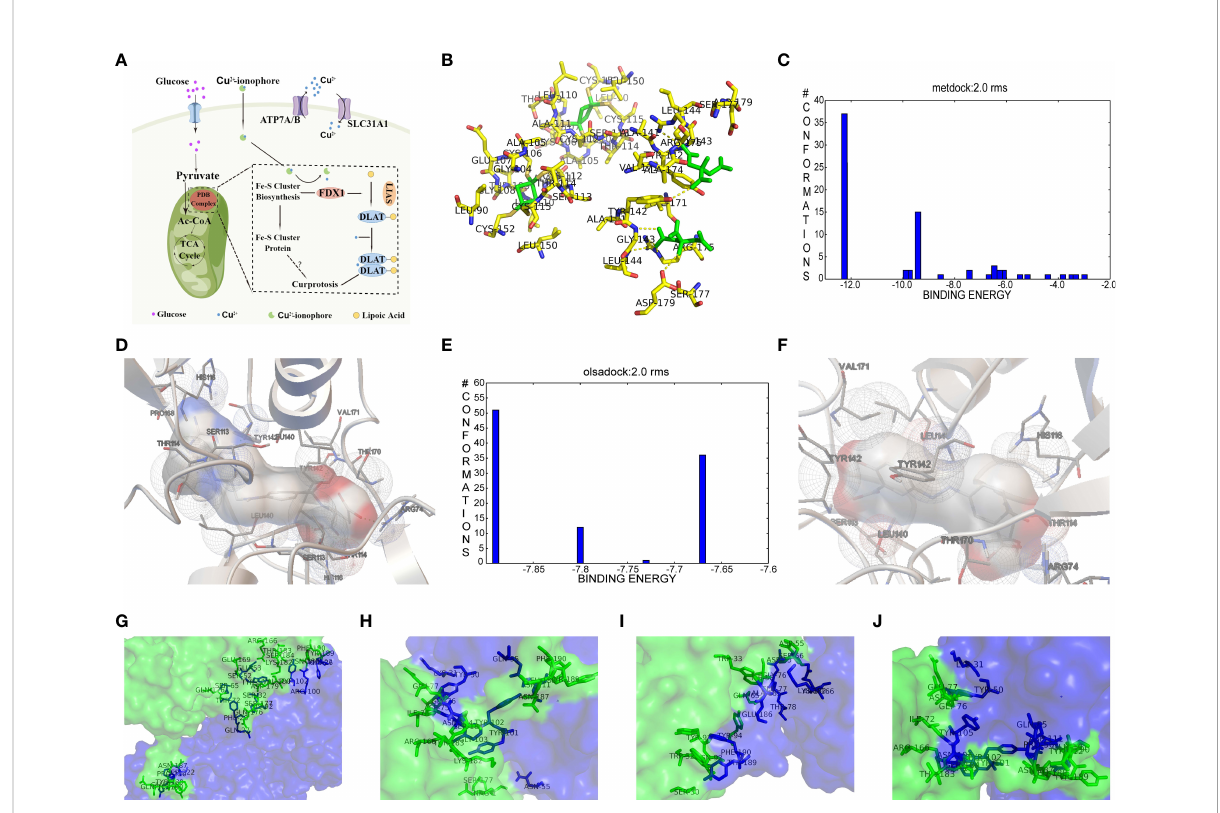
FIGURE 5 Computational simulation of molecular interaction between FDX1 and IBD drugs. (A) Diagram of the regulatory mechanism of cuproptosis. (B) Binding region of FDX1 for Fe-S cluster and citrate anion. (C) Clusterings of 100 docking results of methotrexate based on binding energy. (D) The representative interaction between methotrexate and FDX1. (E) Clusterings of 100 docking results of olsalazine based on binding energy. (F) The representative interaction between olsalazine and FDX1. (G-J) Rigid protein-protein docking images of FDX1 with In fl iximab, Golimumab, Usterkinumab, and Natalizumab,